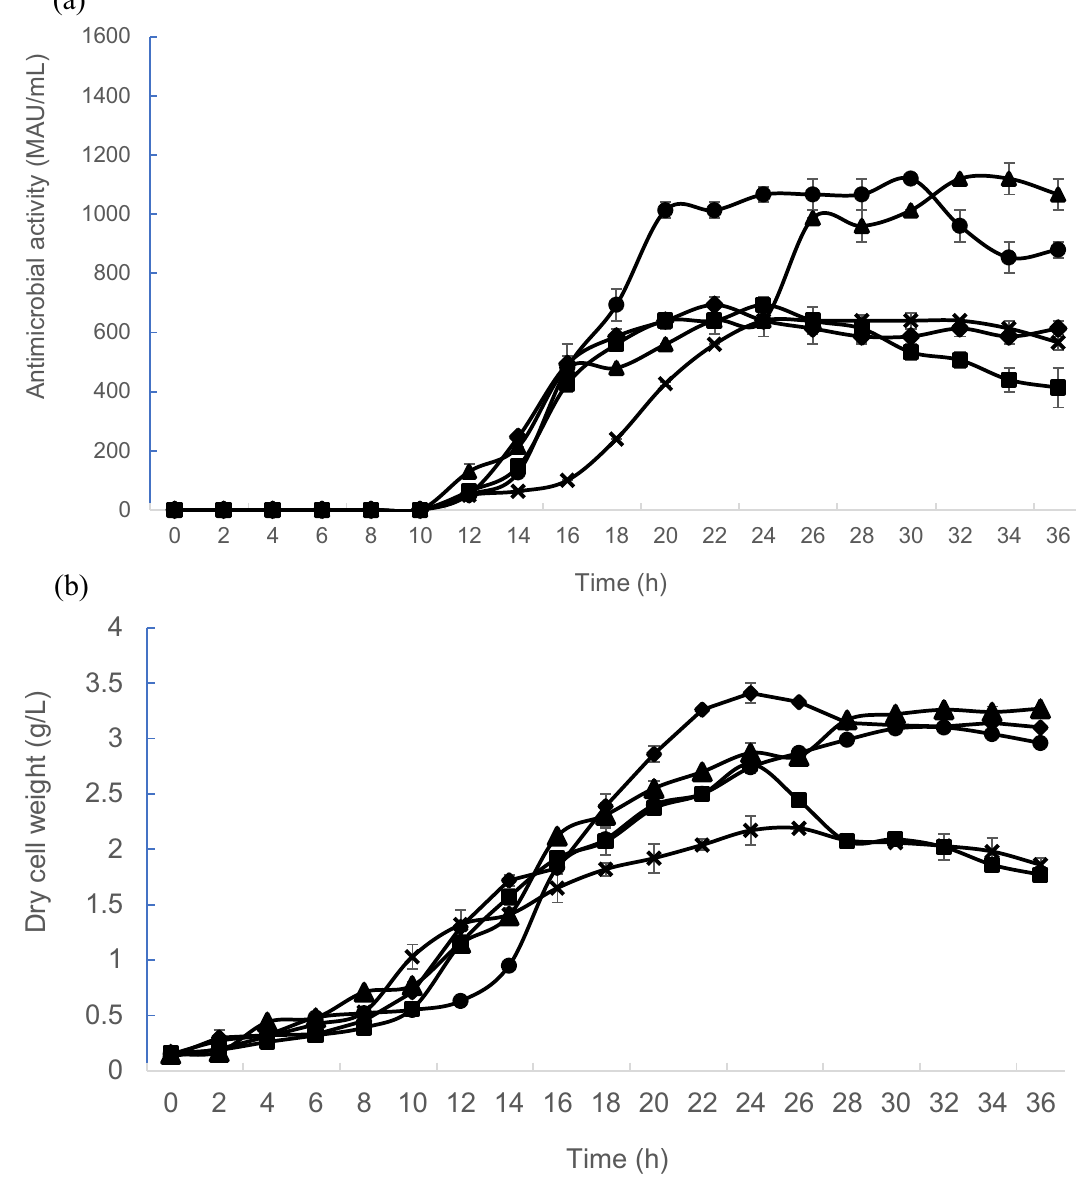
Figure 1. Effects of different yeast extract concentrations on antimicrobial activity of postbiotic RS5 and biomass produced by L. plantarum RS5. ( a ) Antimicrobial activity profiles of postbiotic RS5 and ( b ) growth profile of L. plantarum RS5 in control MRS medium (x) and growth medium containing 11.89 g/L (85.49 mM N) (filled square), 27.84 g/L (200.18 mM N) (filled circle), 36.20 g/L (260.28 mM N) (filled triangle) and 44.55 g/L of yeast extract (320.32 mM N) (filled rhombus). Values presented are mean ± SEM, n = 3. Vertical bars represent